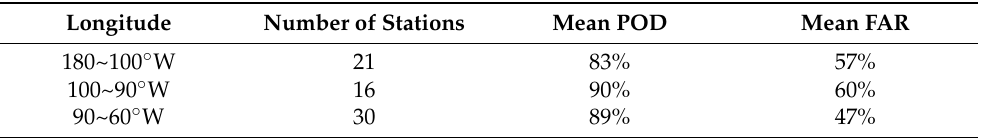
Figure 9. Annual mean rainfall of the 66 rainfall stations. Table 7. Mean POD and FAR values in each of the three parts that were separated according to the annual mean rainfall.